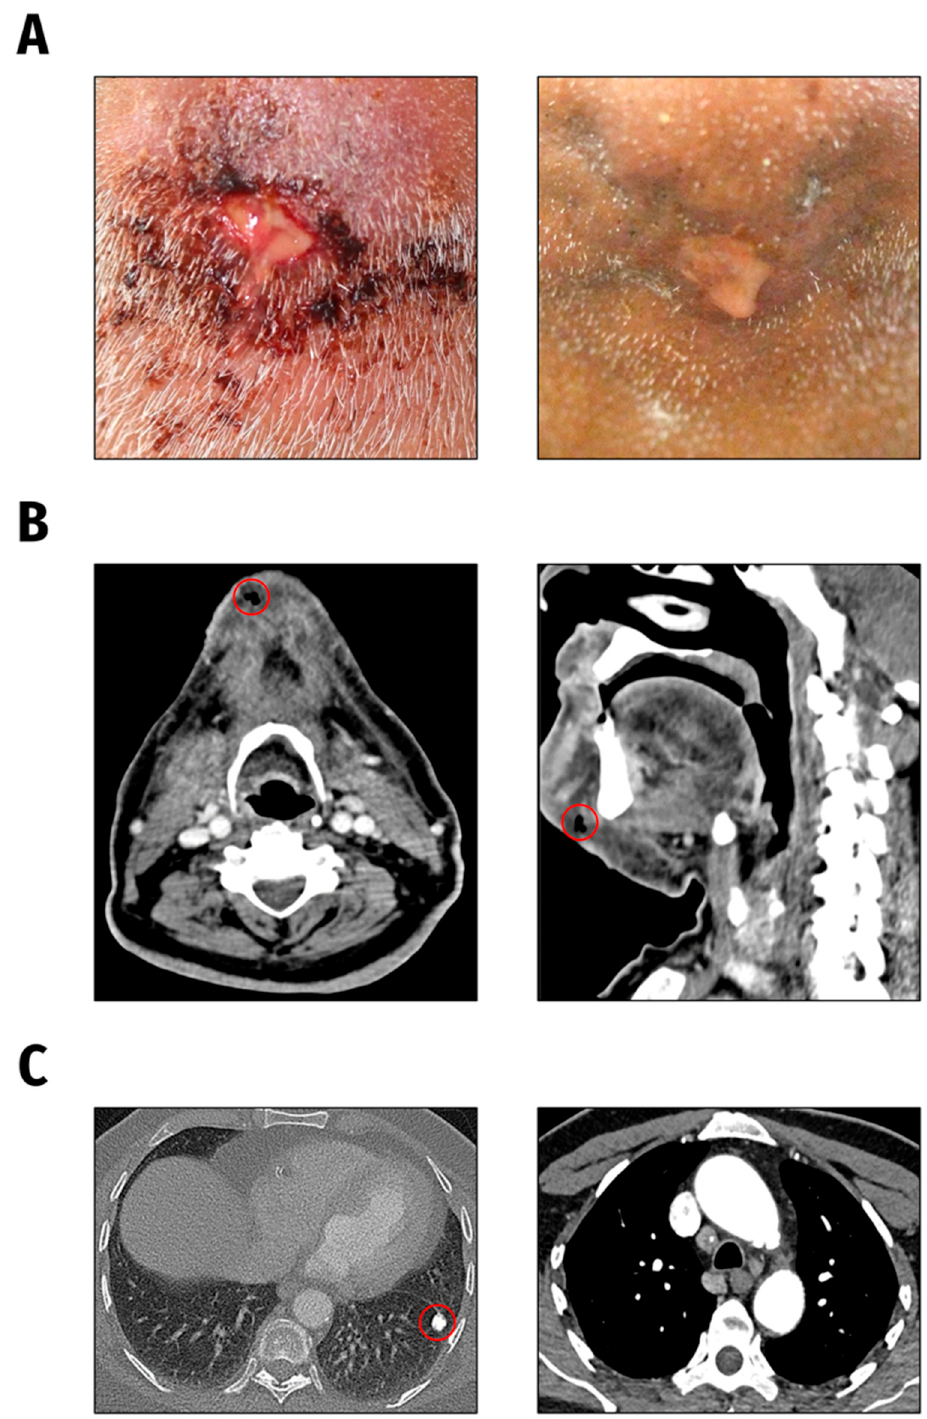
Figure 4. Clinical presentation. ( A ). Submental wound findings at initial presentation (left) and following antibiotic treatment one month later (right). ( B ). CT head and neck findings: subcutaneous air accumulation and circumscribed fluid in the chin region. ( C ). CT chest scan findings: calcified focal lesion in the left lung as well as mediastinal and pulmonary lymphadenopathy.